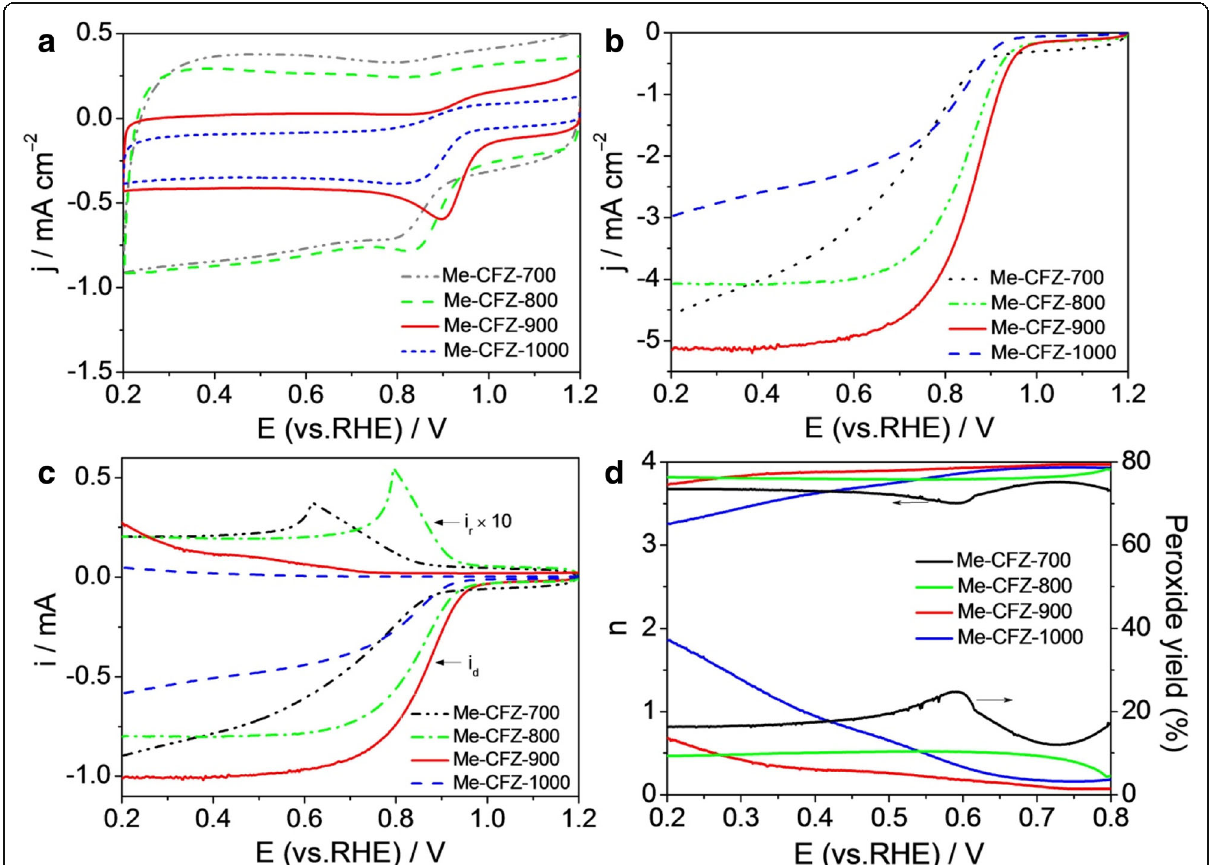
Fig. 6 a CV and b LSV curves of Me-CFZ-700, Me-CFZ-800, Me-CFZ-900, and Me-CFZ-1000 in O 2 -saturated 0.1 mol l − 1 KOH solution. c Disk and ring currents obtained with LSVs on RRDE for Me-CFZ-700, Me-CFZ-800, Me-CFZ-900, and Me-CFZ-1000 in O 2 -saturated 0.1 mol l − 1 KOH solution. d The corresponding electron transfer number and H 2 O 2 yield from